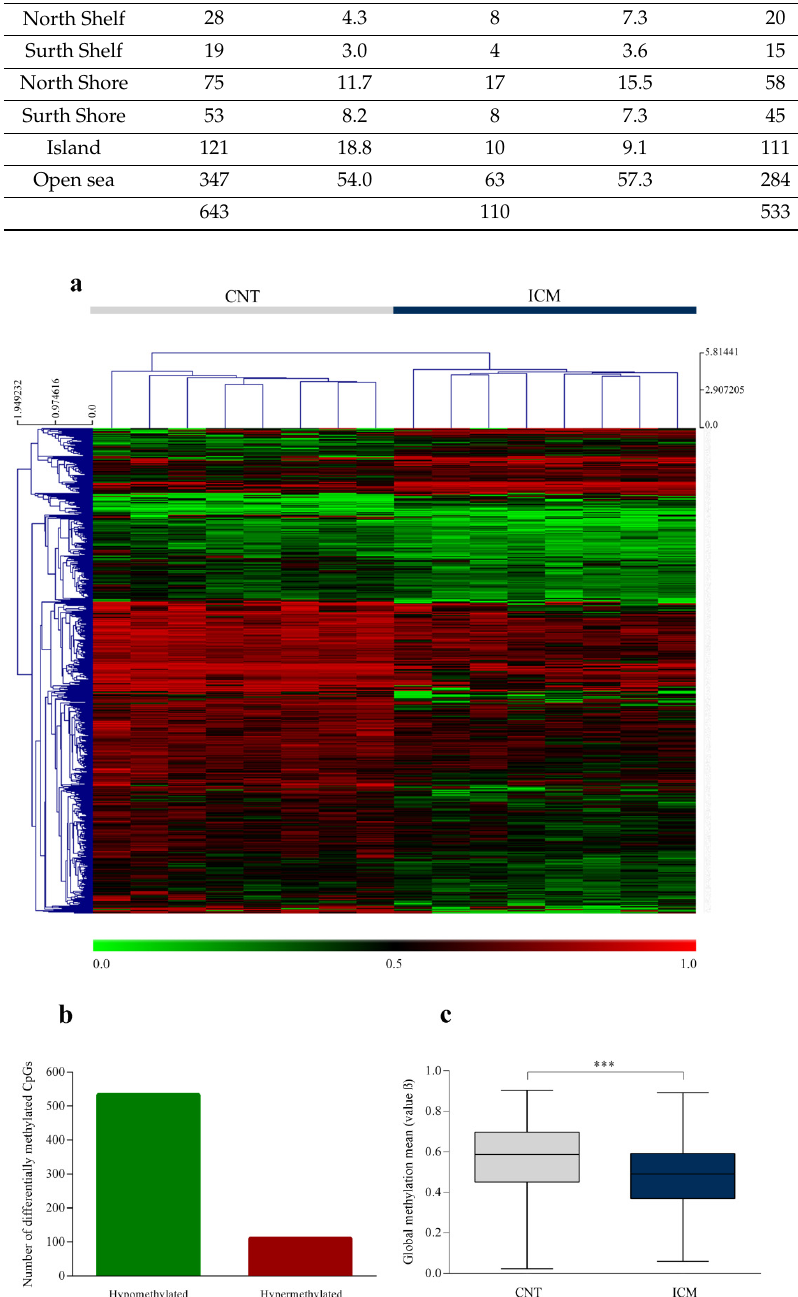
Figure 3. Global CpGs hypomethylation in ischaemic cardiomyopathy patients. ( a ) Heat map representing global methylation in ischaemic hearts ( n = 8) and controls ( n = 8) for each statistically significant CpGs. The results are represented as individual β values (1 = hypermethylated (red) and 0 = hypomethylated (green)). ( b ) Bar graph illustrating the number of hypermethylated and hypomethylated CpGs in ischaemic hearts. ( c ) Box plot graph with global methylation mean. Data are presented as the mean ± SEM. *** p < 0.0001. The results were obtained by the 850 K Infinium MethylationEPIC BeadChip